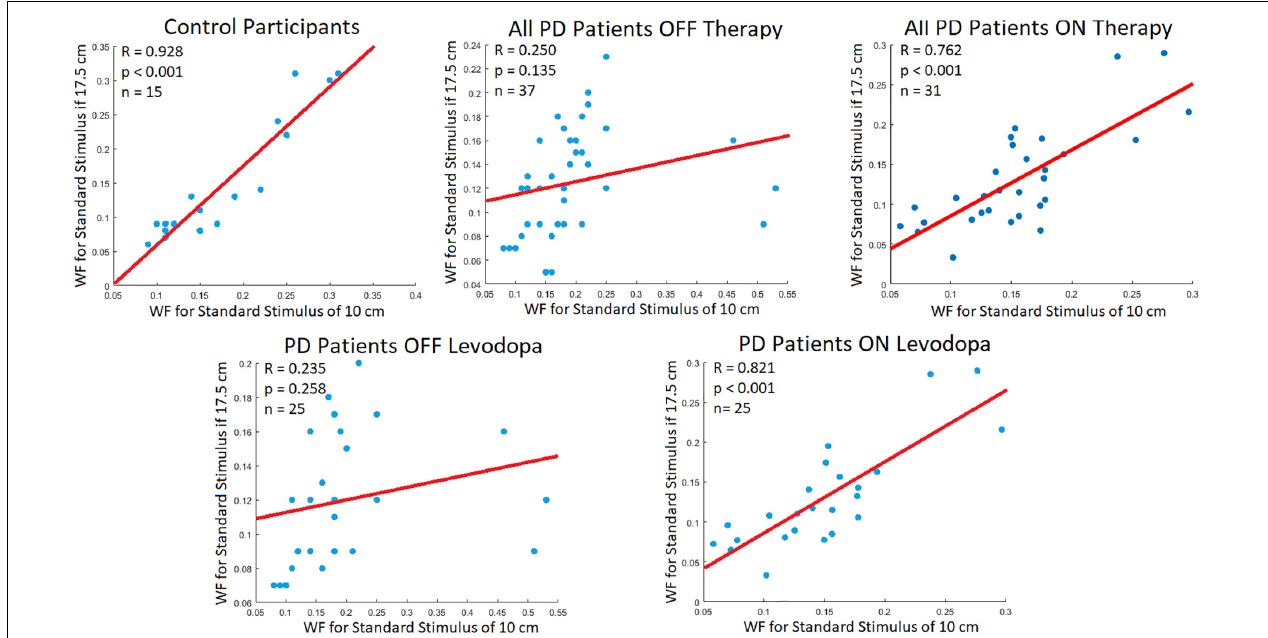
FIGURE 3 | Participant WF Correlation. Correlations (R; Pearson correlation coefficient) between participant WF at the standard stimuli of 10 and 17.5 cm. The red line signifies the line of best fit for the correlation of data points. According to Weber’s Law, there should be strong correlations between WFs of different standard